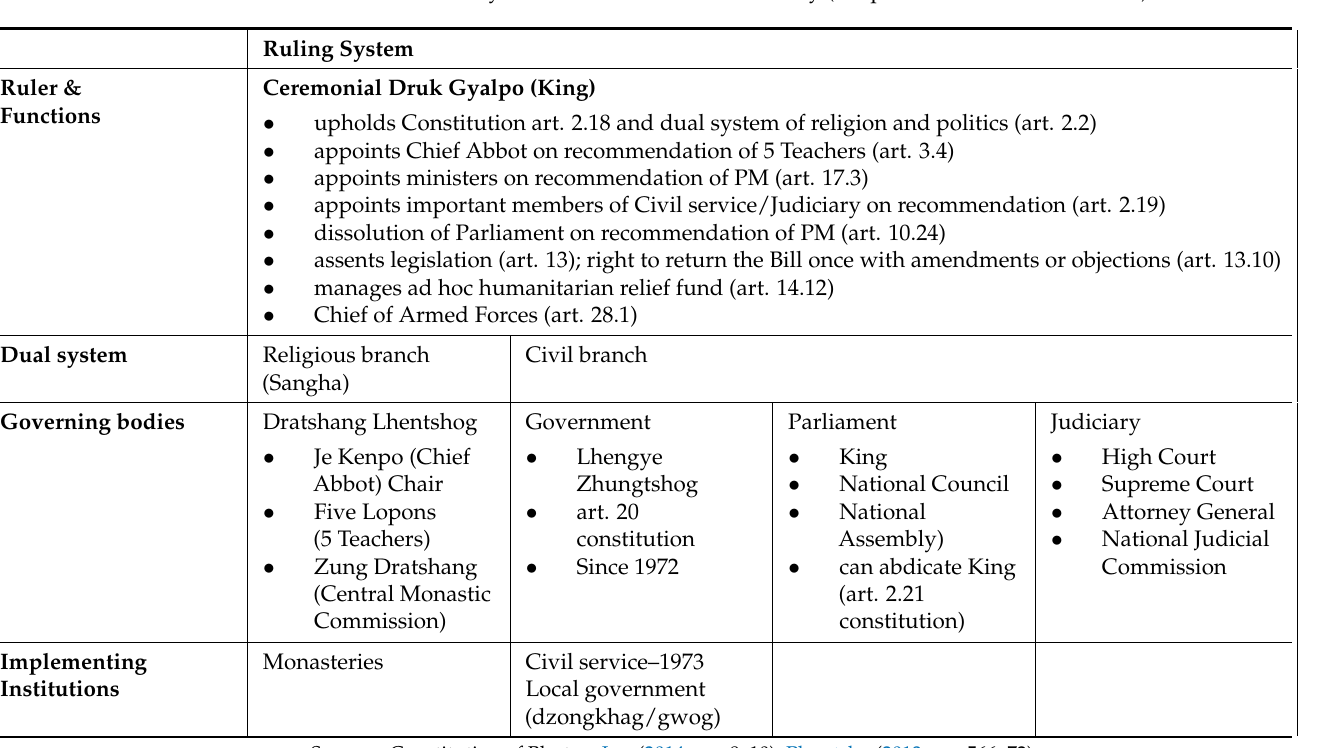
Table 4. Current system of constitutional monarchy (adapted from Van Norren